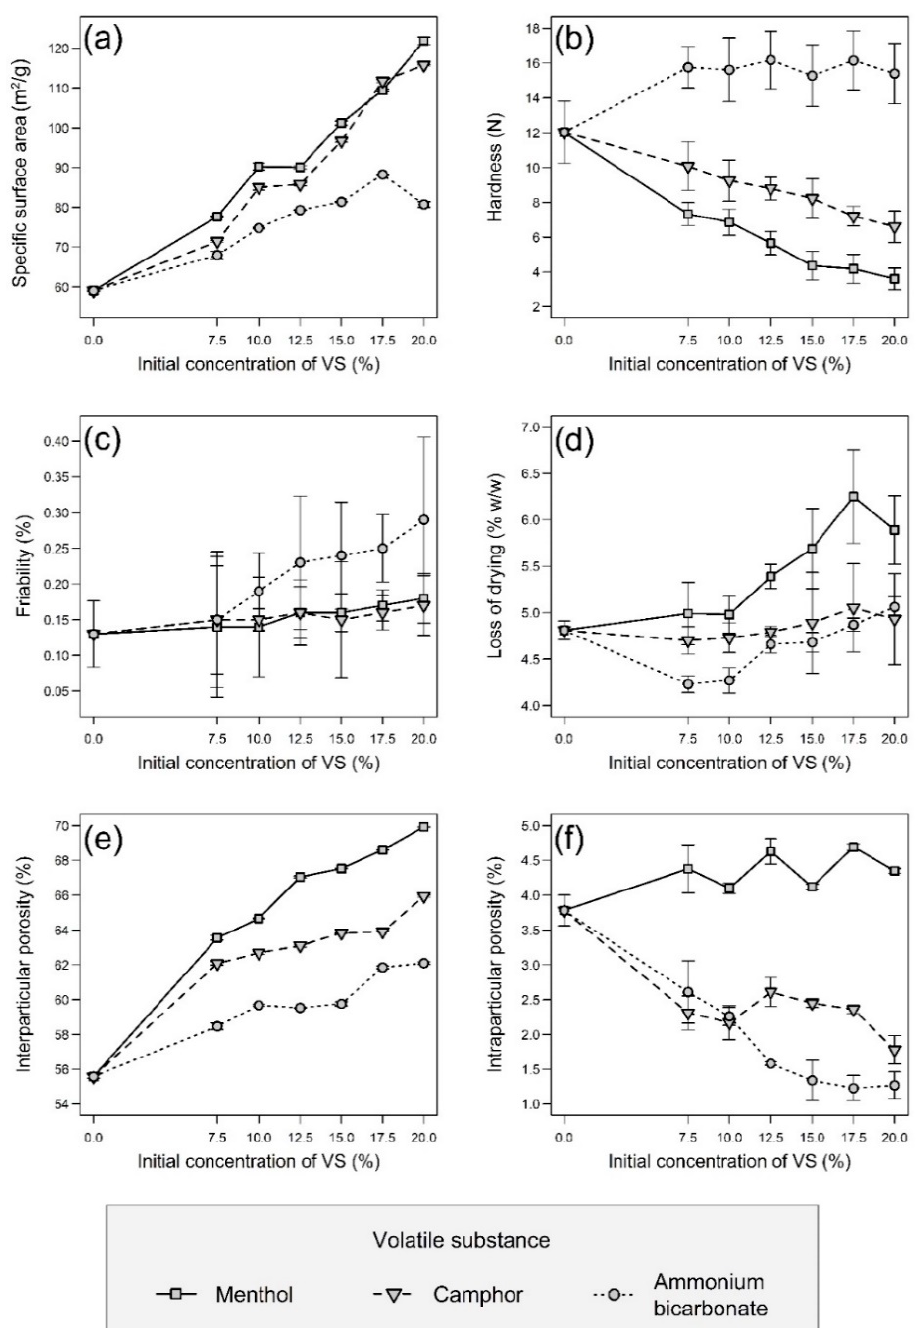
Figure 1. Graphical representation of the results (average values from several measurements) of evaluation of pellets with error bars depending on the volatile substance (VS) used and its concen- tration in the original powder mixture, where the initial concentration of 0.0% always corresponds to the results of sample N: ( a ) specific surface area, ( b ) hardness, ( c ) friability, ( d ) loss of drying, ( e ) interparticular porosity, ( f ) intraparticular porosity.